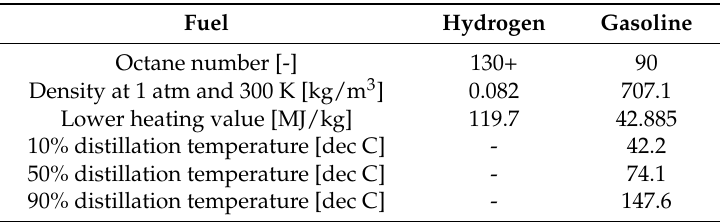
Table 2. Properties of hydrogen and conventional gasoline fuels [18].